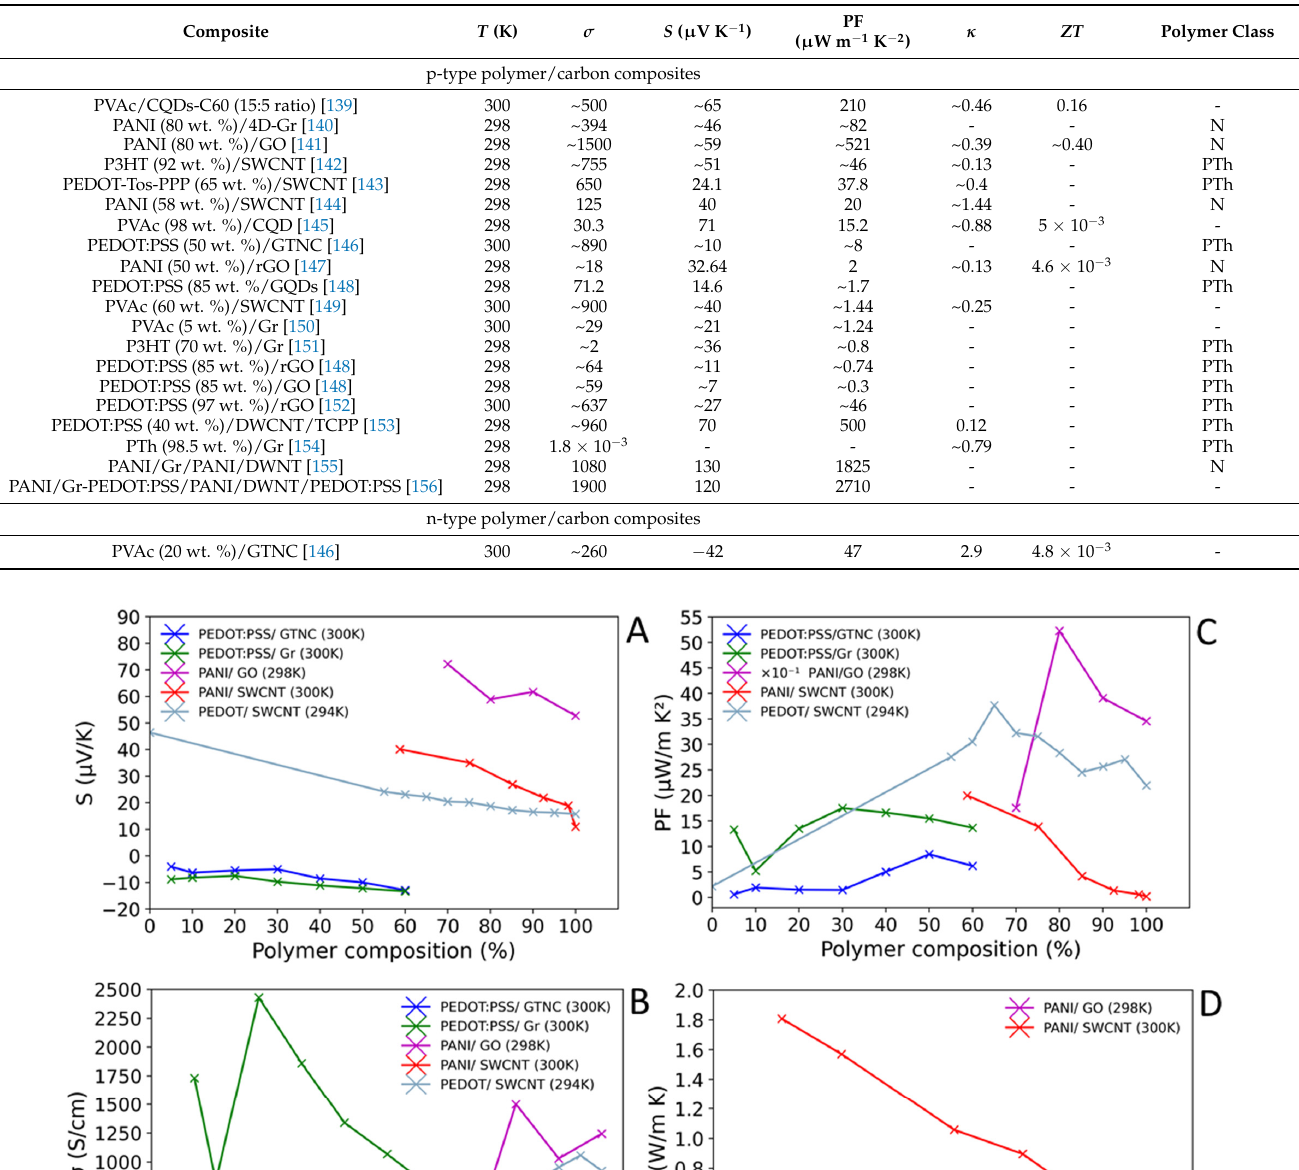
Table 6. Thermoelectric properties of various polymer/carbon composites at a stated tempera- ture ( T ). PVAc = Polyvinyl acetate, CQDs = carbon quantum dots, GTNC = graphene titanium nanocomposite, SWCNT = singled walled carbon nanotubes, DWCNT = double walled carbon nanotubes, rGO = reduced graphene oxide, GO = graphene oxide, Gr = graphene, TCPP = Meso-